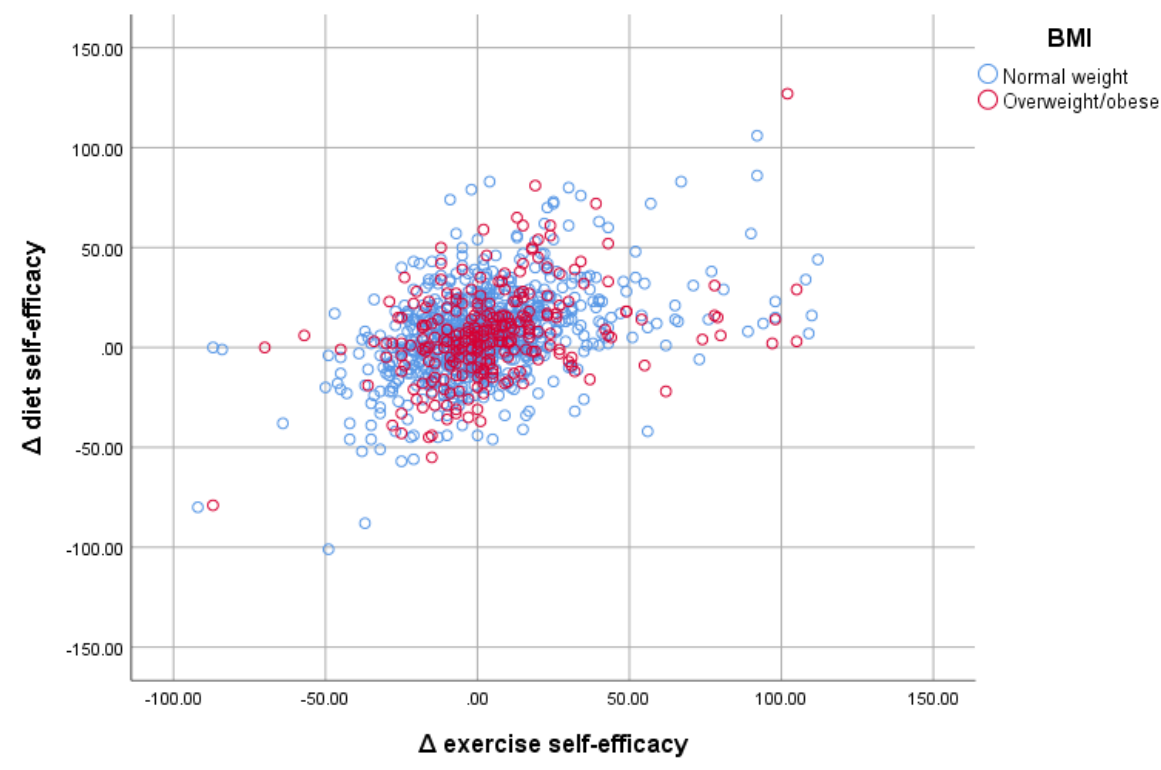
Figure 3. Scatterplot of ( ∆ ) differences (post- vs. pre-intervention) between diet and exercise self- efficacy, presented separately for adolescents with normal weight and overweight/obesity.